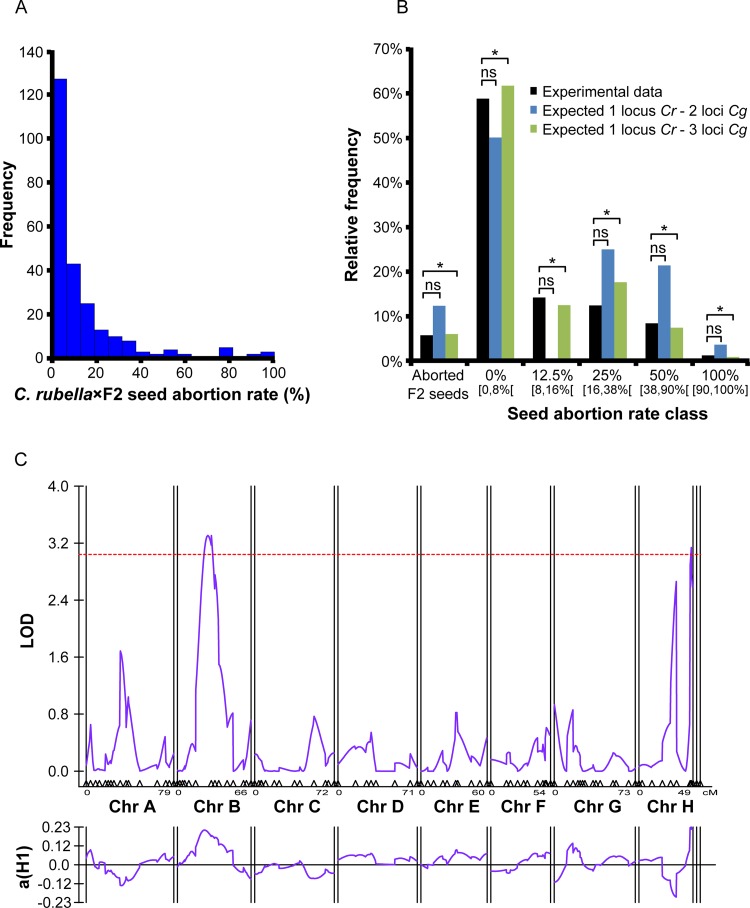

C. rubella × C. grandiflora hybrid seed incompatibility involves multiple genetic loci.(A) Frequency of F2 plants derived from crosses of C. grandiflora × C. rubella producing defined rates of seed abortion when backcrossed to C. rubella maternal plants. (B) Theoretical distribution of F2 plants producing defined rates of seed abortion when assuming that one maternal locus from C. rubella negatively interacts with two or three paternal loci from C. grandiflora. Experimental data correspond to data shown in (A). Significance of the observed distributions with the predictions of the models has been tested by Chi-square and P>0.05 is marked by an asterisk. Ns, non significant. (C) LOD scores for paternal C. grandiflora QTLs affecting abortion of C. rubella × C. grandiflora hybrid seeds. The purple line (top) represents the LOD score of each marker and the purple line (bottom) represents the effects. The red line represents the significance threshold as estimated by 1,000 permutations.